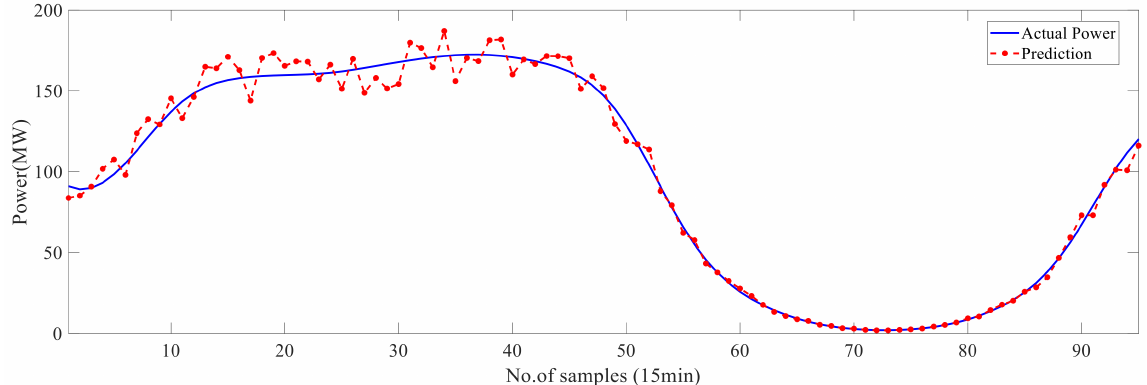
Figure 5. Actual and forecasted output power of wind plant for a winter day.